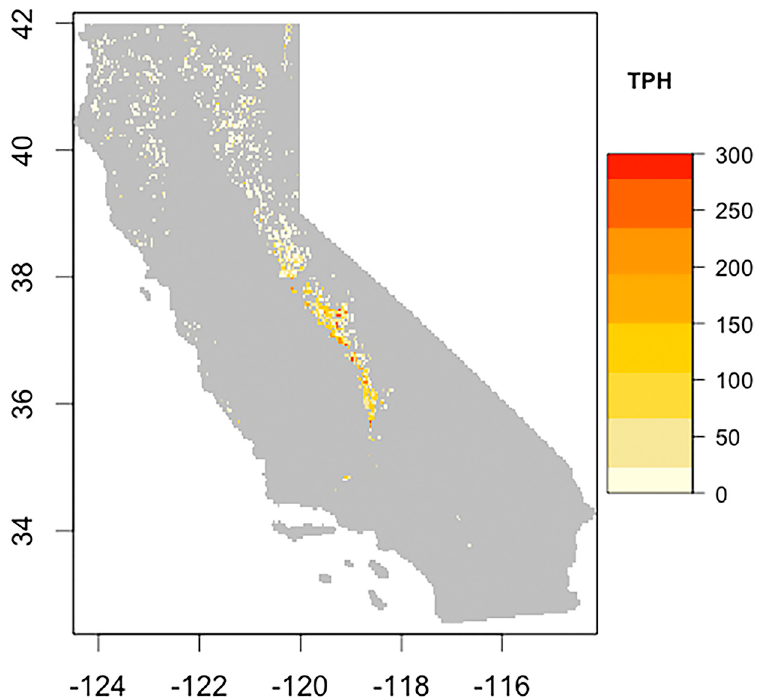
Figure 6. Maximum tree mortality rates (2013–2016) (trees per hectare; TPH). Mortality data was derived from aerial detection surveys of California forest (USFS Region 5) 2013–2016 (http://egis.fire.ca.gov/TreeMortalityViewer/Help.html). Latitude and longitude are shown along the axes.